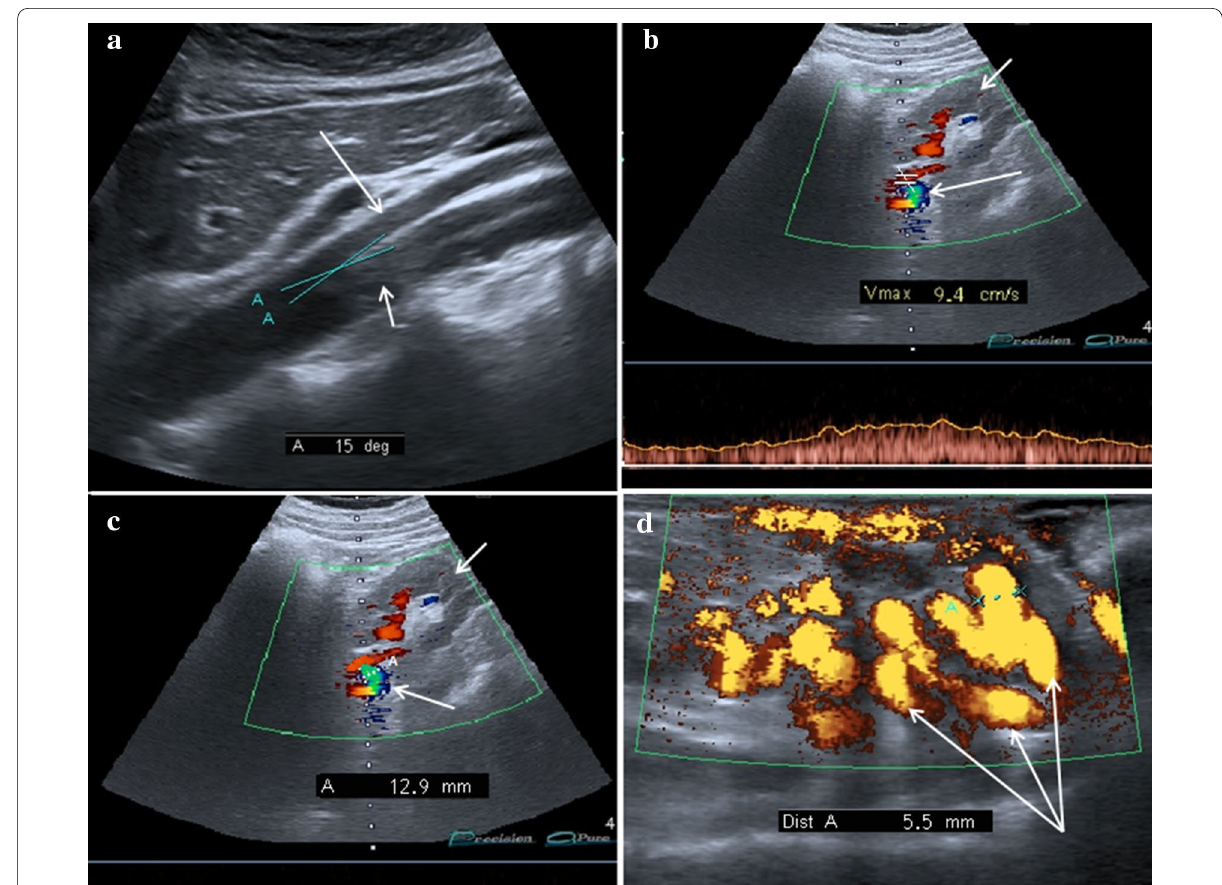
Fig. 7 B-Mode US: longitudinal sub-xiphoid scan of the abdominal aorta performed in supine decubitus. a Measurement of the aorto-mesenteric angle "A" in patient with NCS. Abdominal aorta (short arrow). Superior mesenteric artery (long arrow). b Duplex Doppler US shows a peak speed reduction in left renal vein. c Measurement of the left renal vein diameter. d Power Doppler US shows varicosity of the gonadal plexus (vein diameter 5.5